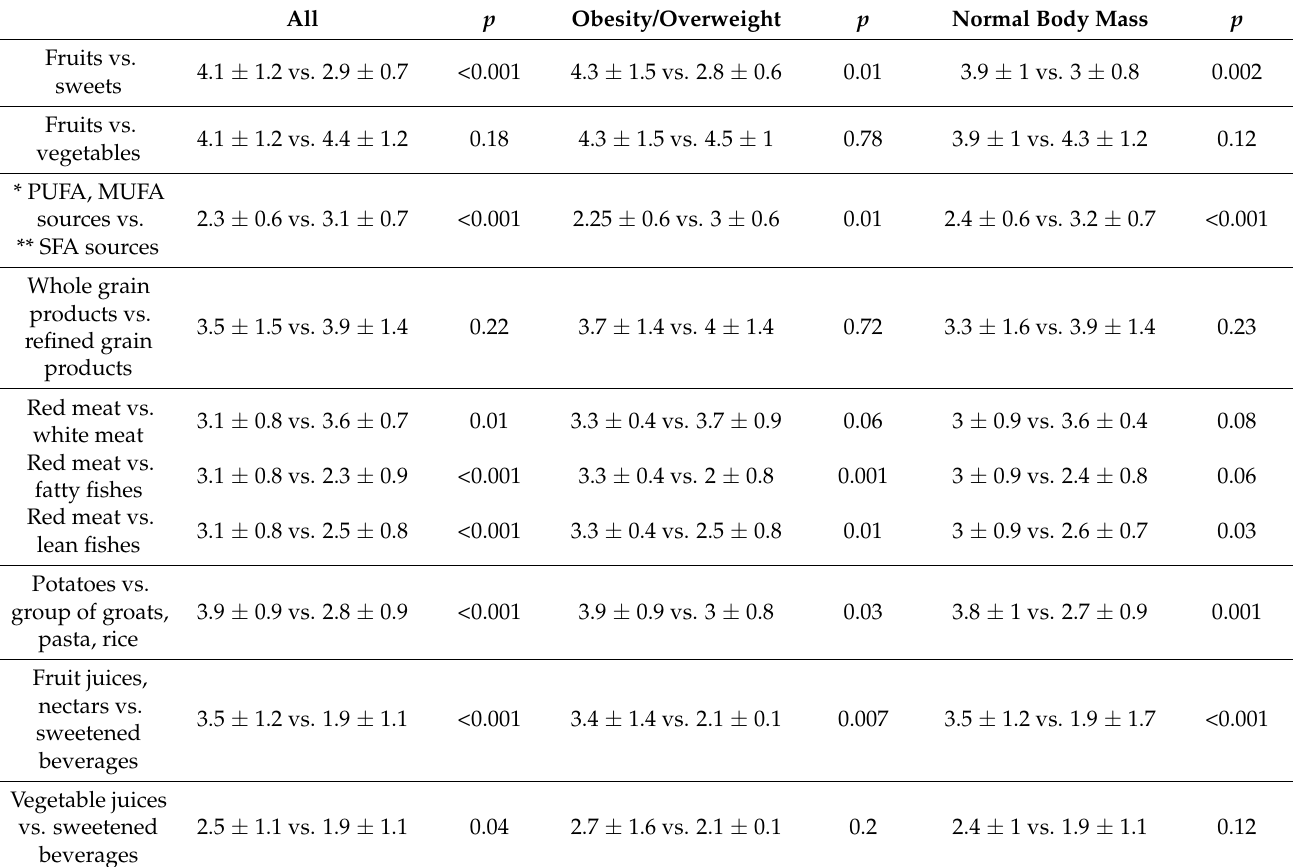
Table 7. The comparison of the frequency of eating the main group of food